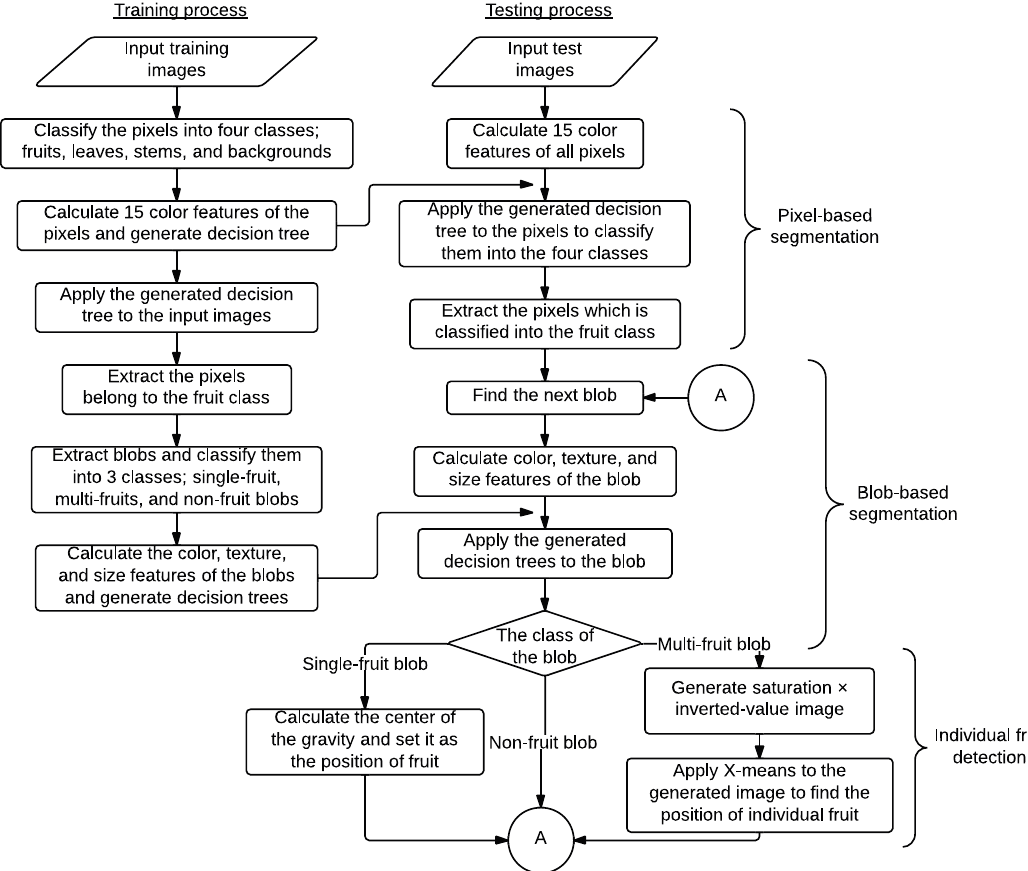
Figure 1. Flowchart of the developed